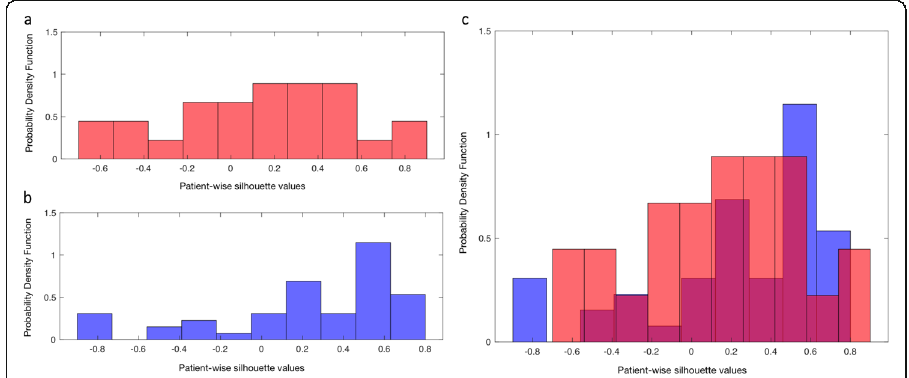
Fig. 3 Histograms of the silhouette values. Histogram of the silhouette values of lymph nodal lesions in non-